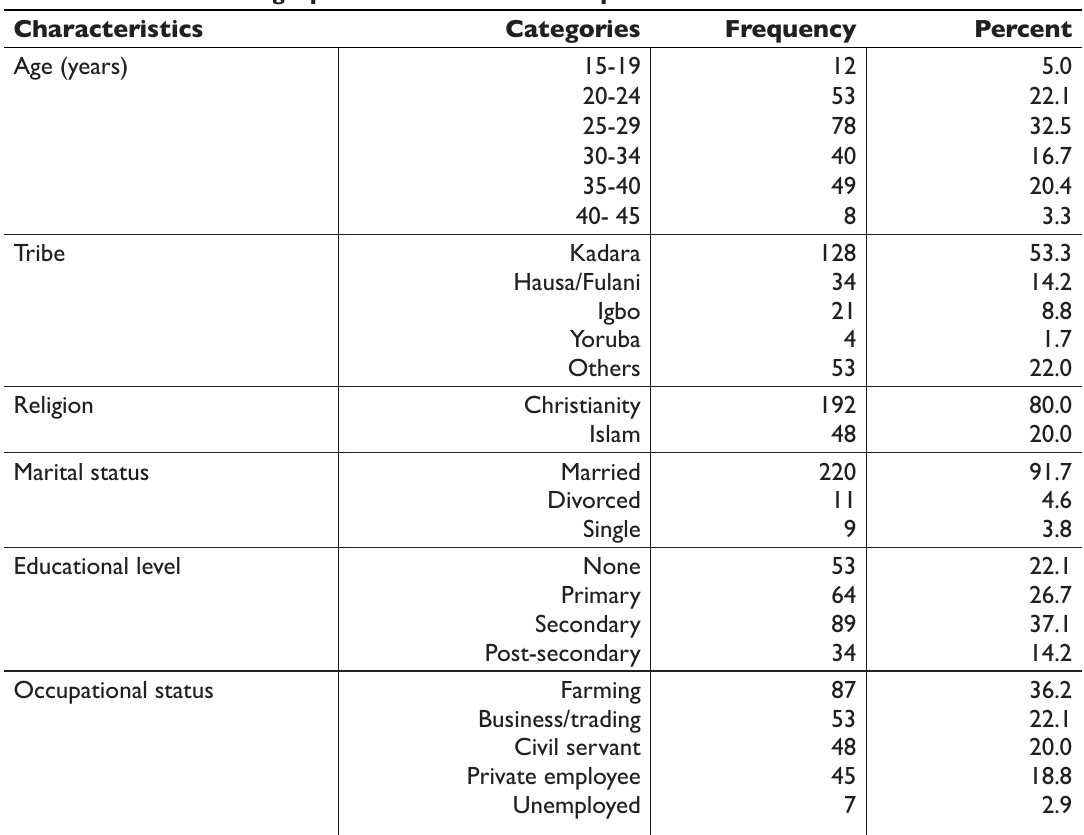
Table 1. Socio-demographic characteristics of